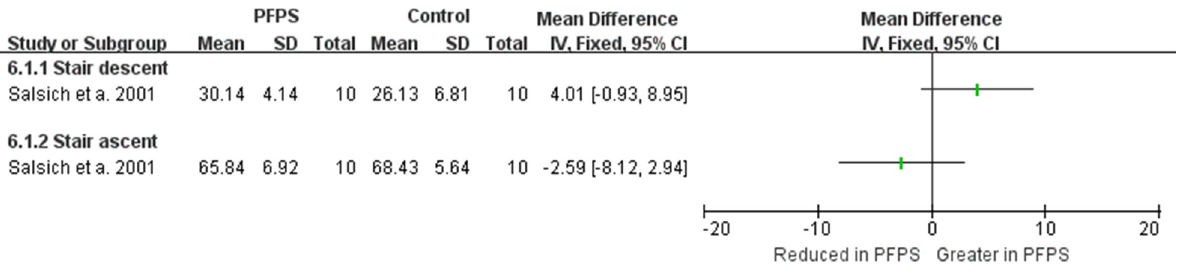
Figure 3. Hip flexion angle between the PFPS and control in different functional activities.